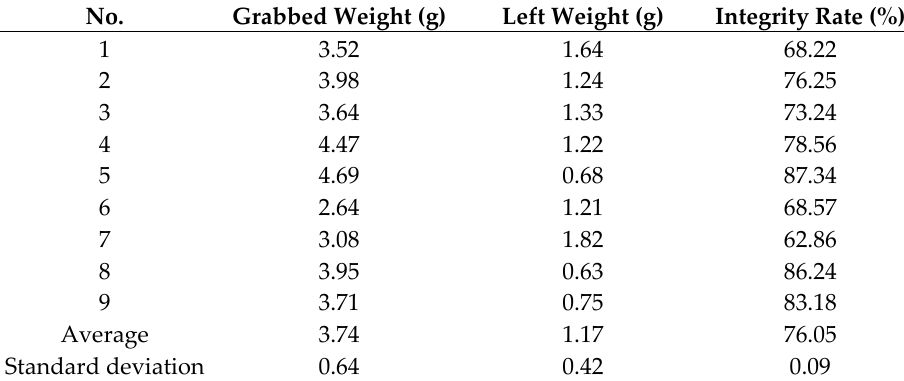
Table 5. Grab test results of the optimized gripper.